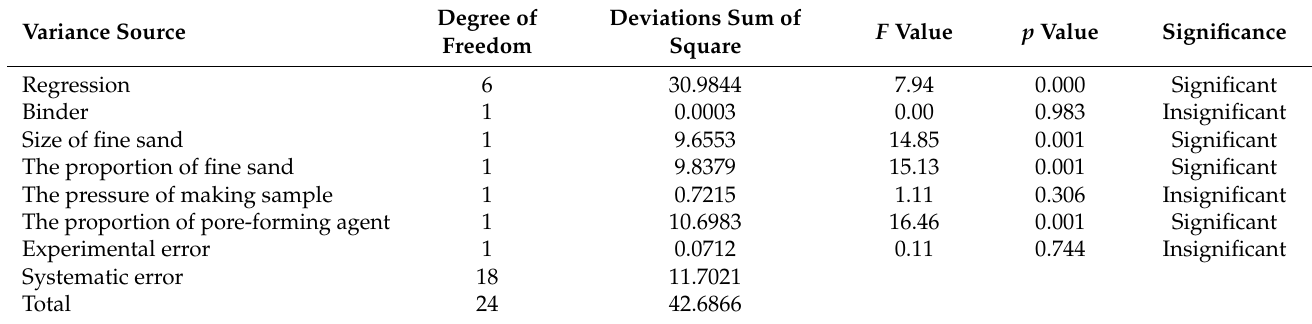
Table 4. Variance analysis of compressive